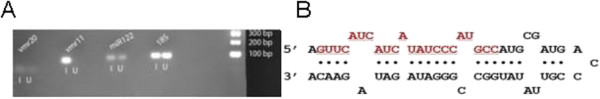
The HCV derived viral small RNAs. (A) Quantitation of vmrs: RT-PCR results show robust increase in vmr11 levels six days post-transfection with HCV genomic RNA, and only minimal change in vmr20. (I, infected; U, uninfected). As control, miR-122 level is minimally changed upon viral infection. (18S marker served as internal reference). (B) Structure of vmr11 RNA: Predicted secondary structure of vmr11 precursor. Mature vmr11 RNA is shown in red.